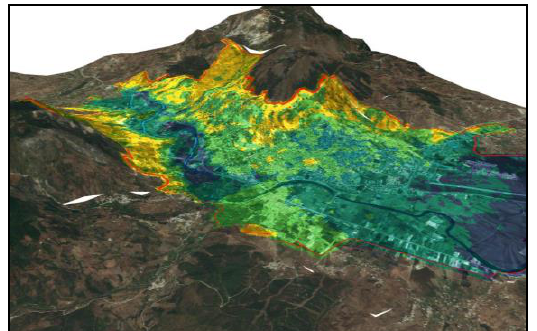
Figure 6 : RF model with another 3D view